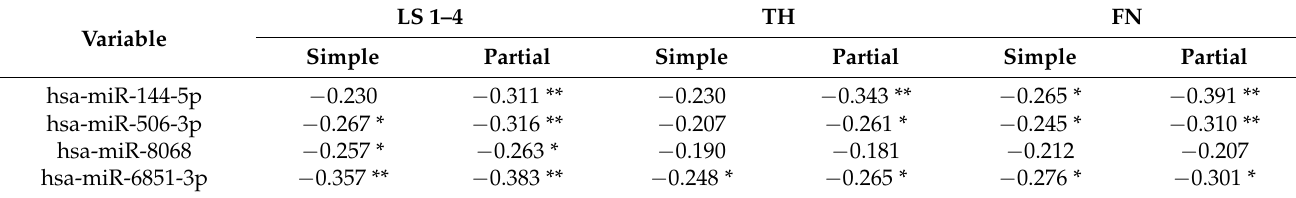
Table 3. Correlations between key miRNAs and BMD (g/cm 2 ) at different body